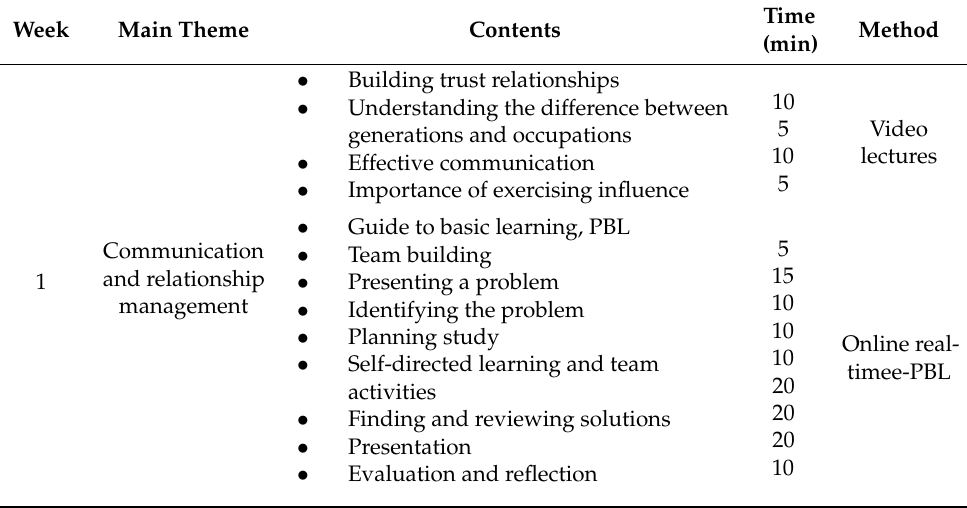
Table 1. Overview of the program process by